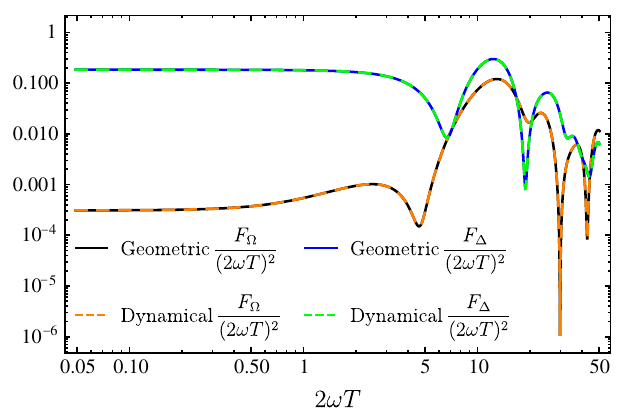
FIG. 5. A comparison of the geometric and dynamical X π/ 2 gate filter functions for additive dephasing and multiplicative amplitude noise when (cid:11) max = 1. We verify that the two control Hamiltonians produce the same filter functions.